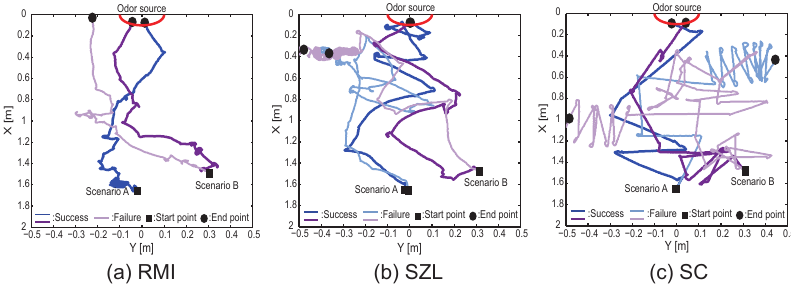
Figure 6. Typical trajectories for scenarios A and B.